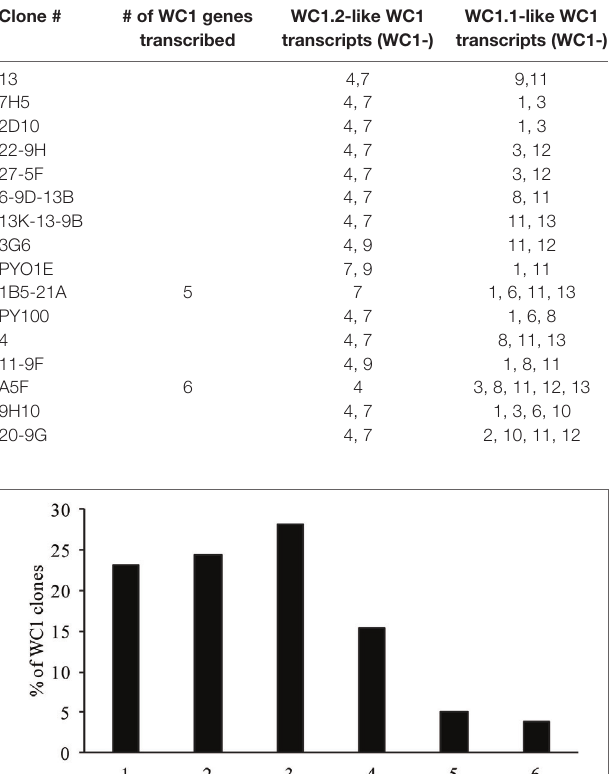
Table 3 | Summary of WC1 transcripts expressed by γδ T cell